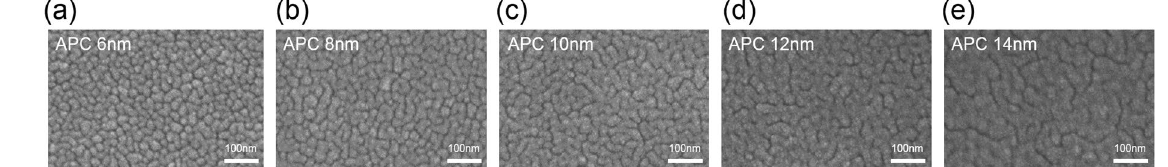
Figure 3. Surface FESEM images of thermally evaporated APC films on a PET substrate with a thickness of ( a ) 6 nm, ( b ) 8 nm, ( c ) 10 nm, ( d ) 12 nm, and ( e ) 14 nm,